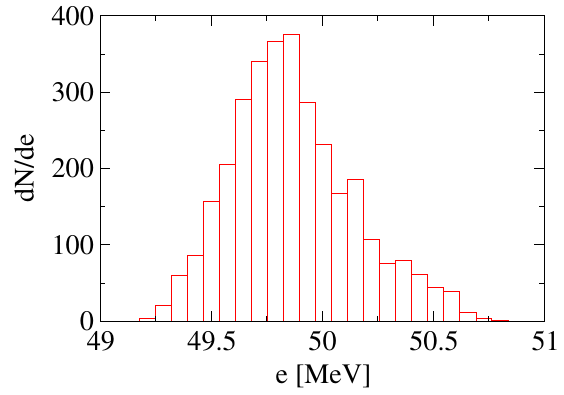
FIG. 13. UAL output energy distribution.